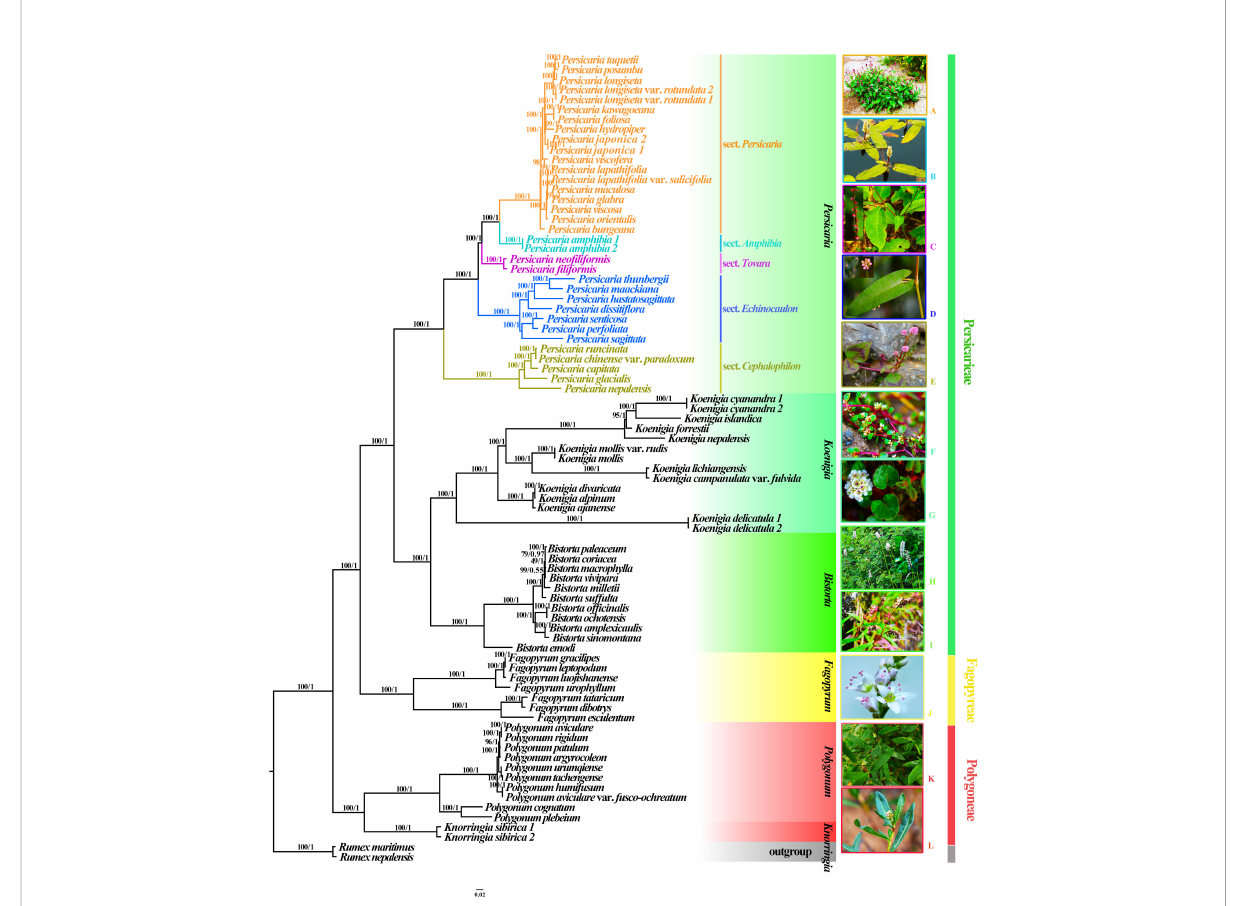
FIGURE 1 ML and BI phylogenetic trees based on complete plastomes of 80 samples. Rumex maritimus and R. nepalensis were set as the outgroup, major clades are indicated by different colors. Numbers above each branch indicate ML bootstrap values (BS) and BI posterior probabilities (PP). (A) , Persicaria posumbu (sect. Persicaria ); (B) , P. amphibia (sect. Amphibia ); (C) , P. fi liformis (sect. Tovara ); (D) , P. sagittata (sect. Echinocaulon ); (E) , P. capitata (sect. Cephalophilon ); (F) , Koenigia islandica ; (G) , K. forrestii ; (H) , Bistorta of fi cinalis ; (I) , B. emodi ; (J) , Fagopyrum esculentum ; (K)